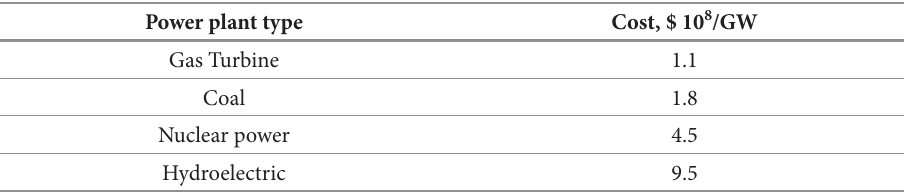
Table 2. Investment costs for power